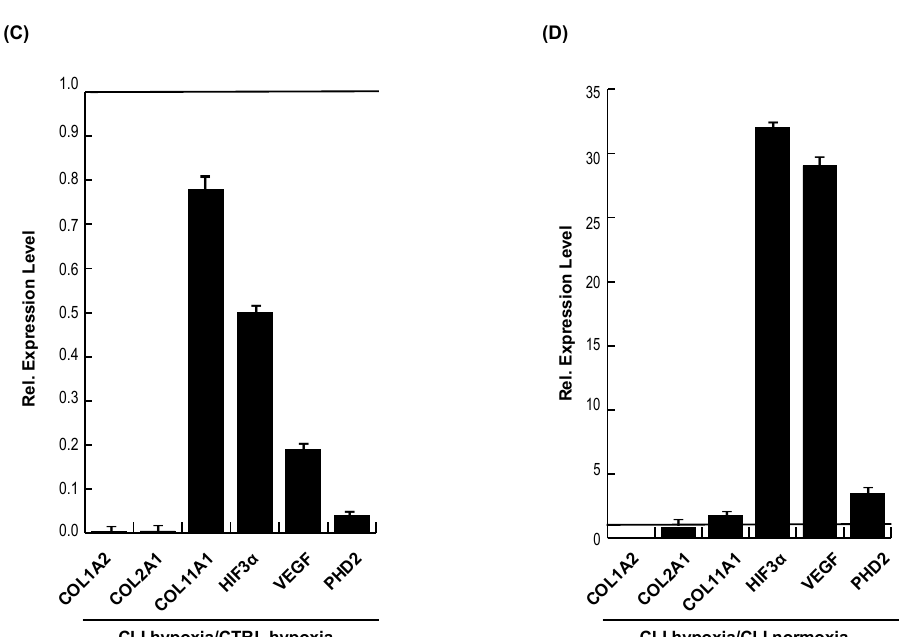
Figure 4. Relative expression levels of miR-29b targets analyzed by RT-PCR in CTRL hypoxia/CTRL normoxia ( A ), CLI normoxia/CTRL normoxia ( B ), CLI hypoxia/CTRL hypoxia ( C ) and CLI hypoxia/CLI normoxia ( D ). Data are the result of three independent experiments each with three replicates, and are represented as ± SEM. EAR was used for data normalization for gene expression. p -value ≤ 0.01.